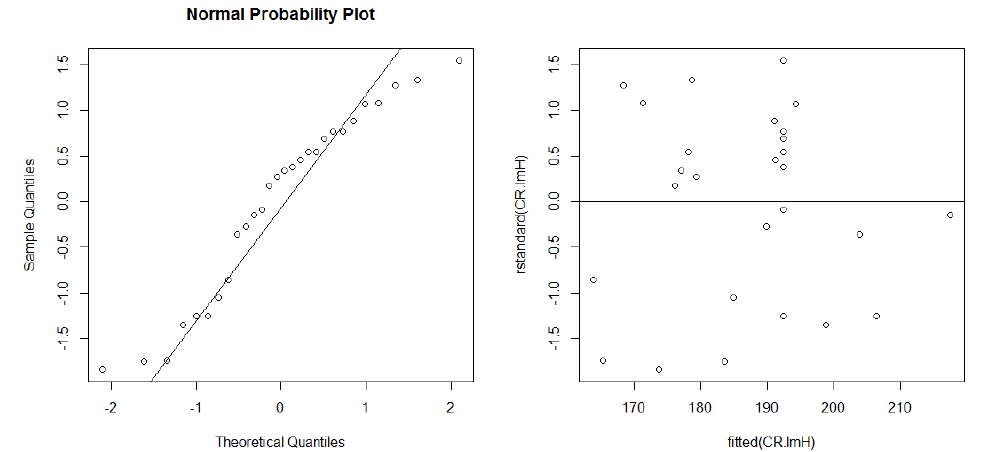
Figure 10. Normal probability plot of residuals, and plot of residuals vs. fitted values, for hole width